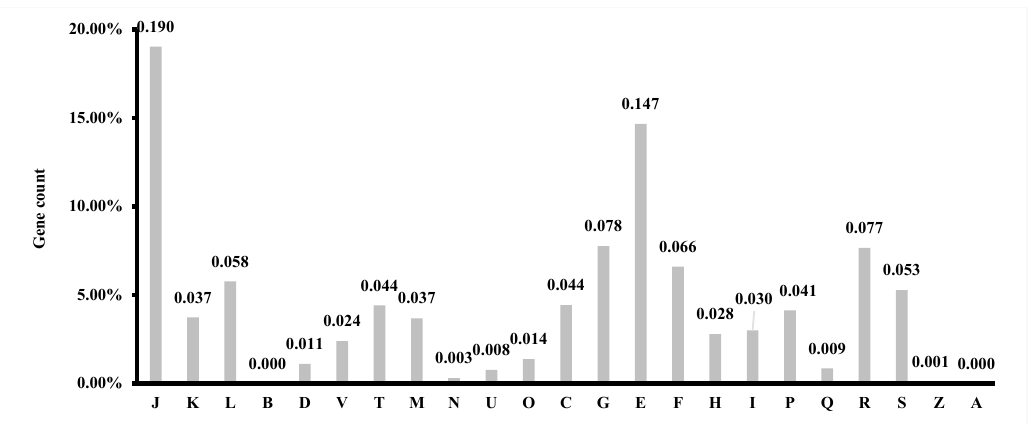
Figure 3. Annotation of a core genome based on the COG database. A: RNA processing and modi- fication, B: Chromatin structure and dynamics, C: energy production and conversion, D: cell cycle control, cell division, chromosome partitioning, E: amino acid transport and metabolism, F: nucleotide transport and metabolism, G: carbohydrate transport and metabolism, H: coenzyme transport